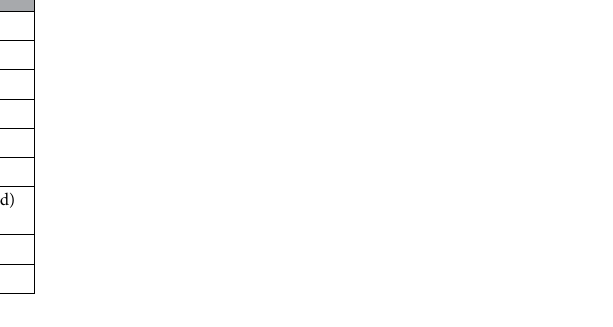
Table 2. ICP-MS operation